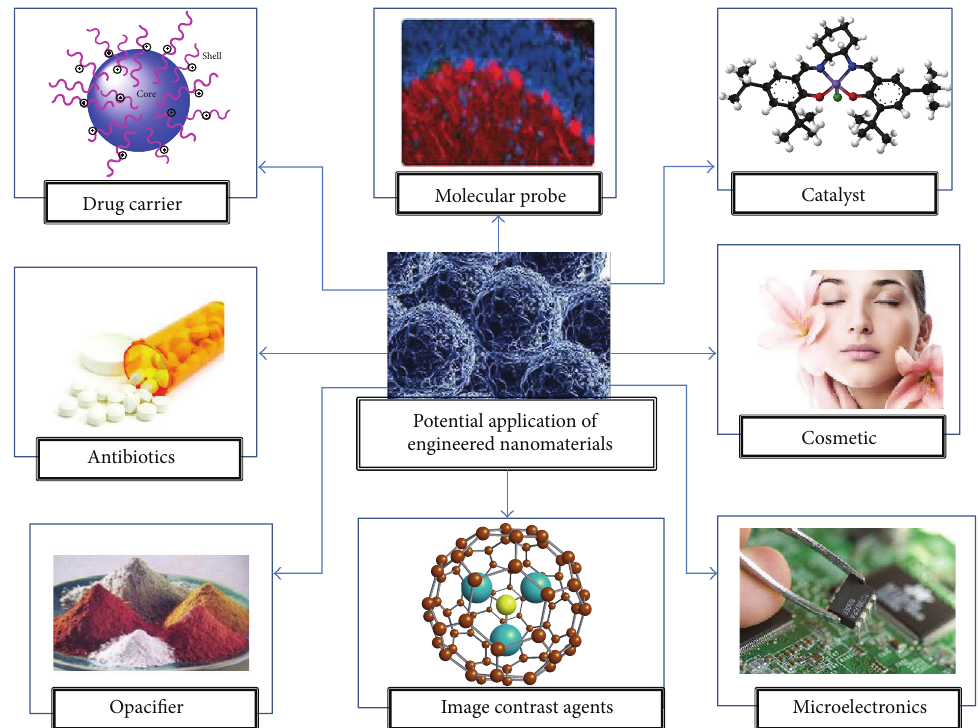
Figure 1: List of carbon-based nanomaterials potential applications.